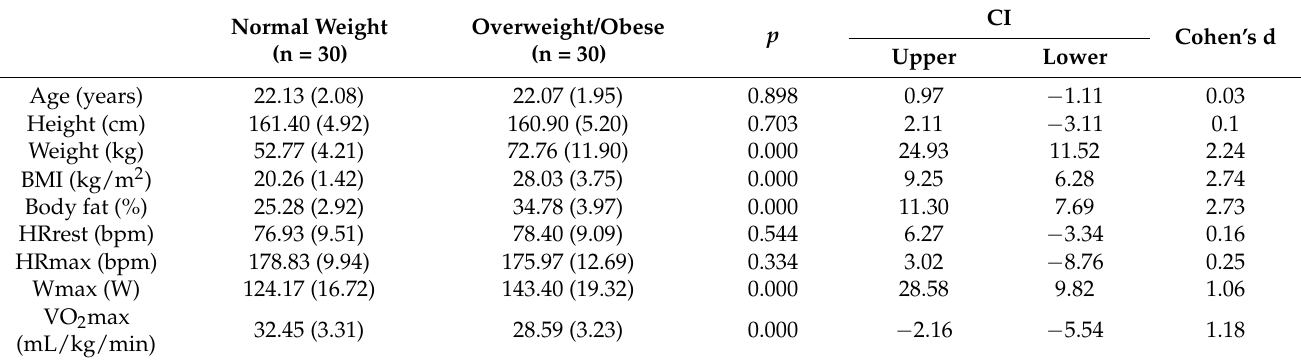
Table 1. Participant’s